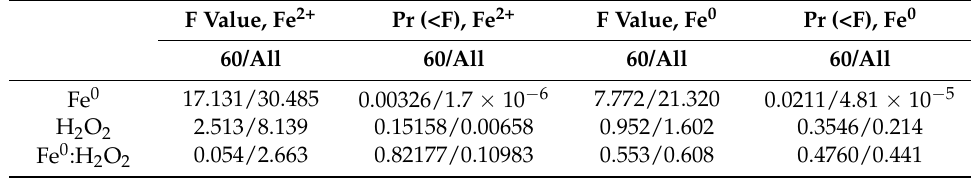
Table 6. ANOVA (analysis of variance) results for TOC and Fe 2+ /Fe 0 , time 60 (min) vs. all process times. F Value, Fe 2+ Pr (<F), Fe 2+ F Value, Fe 0